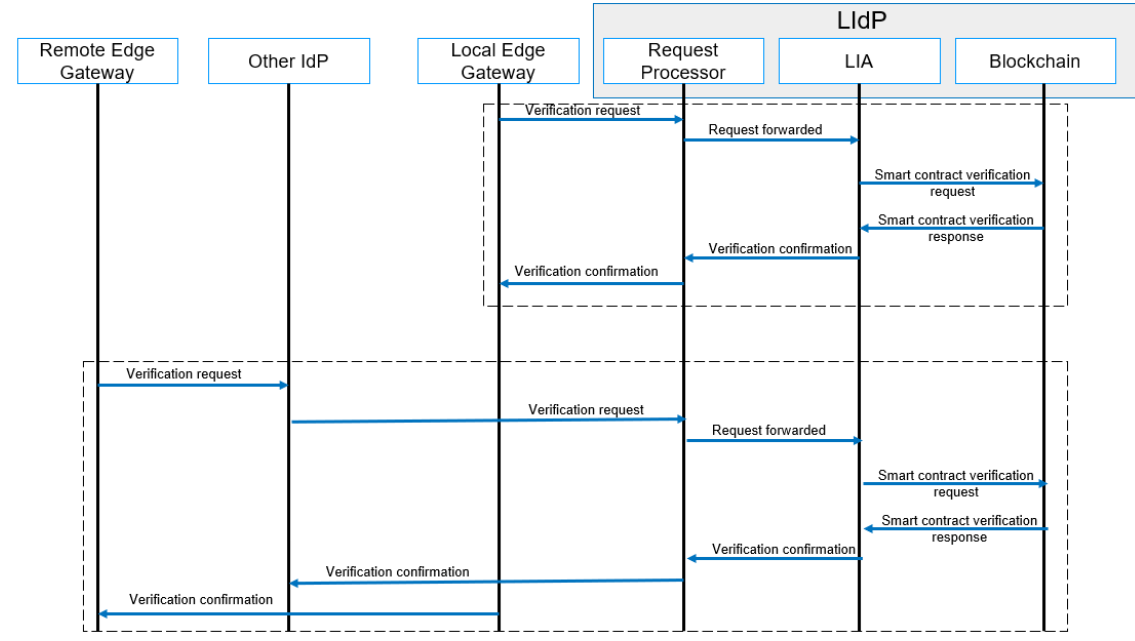
Figure 9. Authentication/Authorization process message flow.